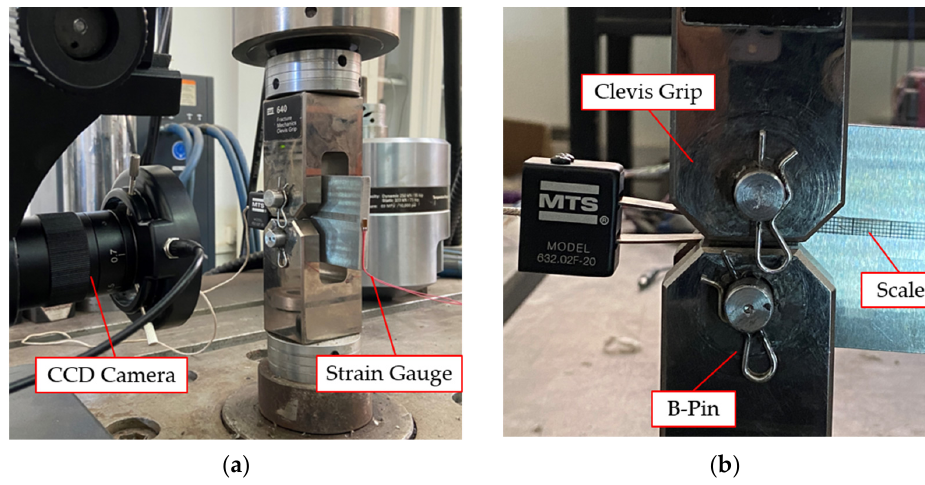
Figure 2. Measurement system: ( a ) global; ( b ) local.